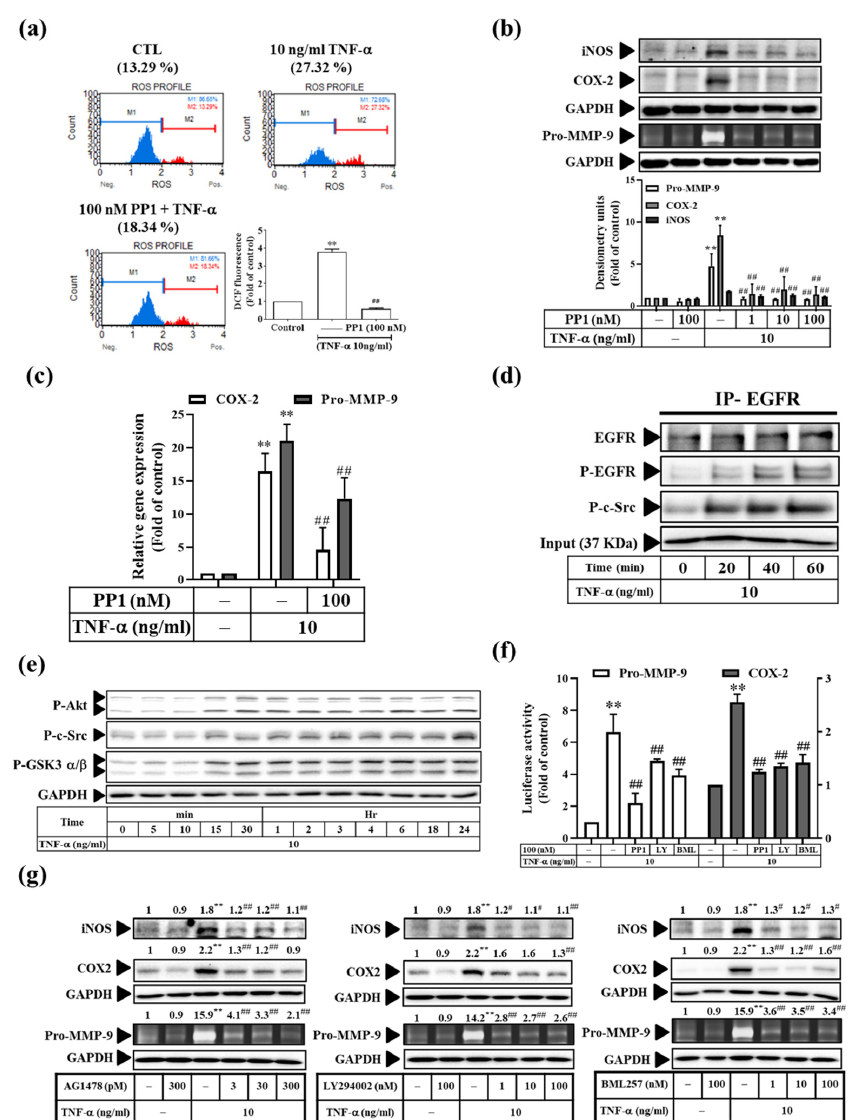
Figure 6. The c-Src/EGFR/PI3K/Akt/GSK3 α / β pathway in TNF- α -induced COX-2 and pro-MMP- 9 expression. ( a ) Cells were pre-treated with various concentrations of PP1, followed by TNF- α treatment for 6 h, collection of cells (1 × 10 6 cells/mL), staining of free radicals with DHE, and ( b ) PP1 and ( g ) AG1478, LY294002, or BML257, followed by TNF- α treatment for 24 h (for